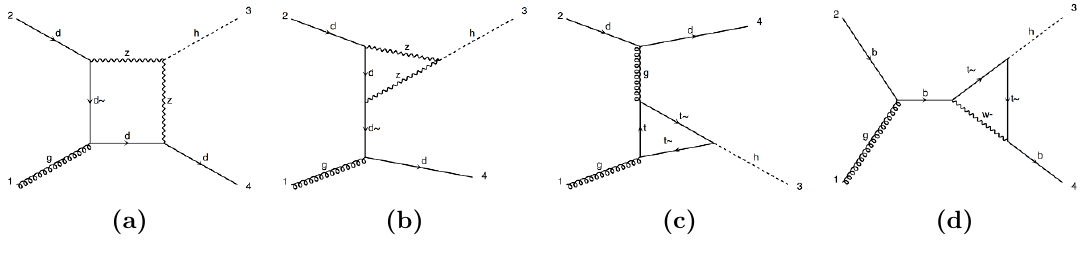
Figure 2 . Diagrammatic contributions to the amplitudes A ( (cid:0) 1 ; 2) ((cid:12)gures 2a, 2b, 2d) and A (1 ; 0) gq ! Hq gq ! Hq ((cid:12)gure 2c), yielding (cid:27) ( (cid:0) 1 ; 2) and (cid:27) (0 ; 2) respectively. Diagrams 2a and 2b also appear in the gq ! Hq gq ! Hq reduced matrix elements factorised by the collinear subtraction local counterterms of eqs. (3.2) Hb . In and (3.1). Notice that diagrams belonging to the class 2d are speci(cid:12)c to the process gb ! all cases, the full top-quark mass dependence is retained.